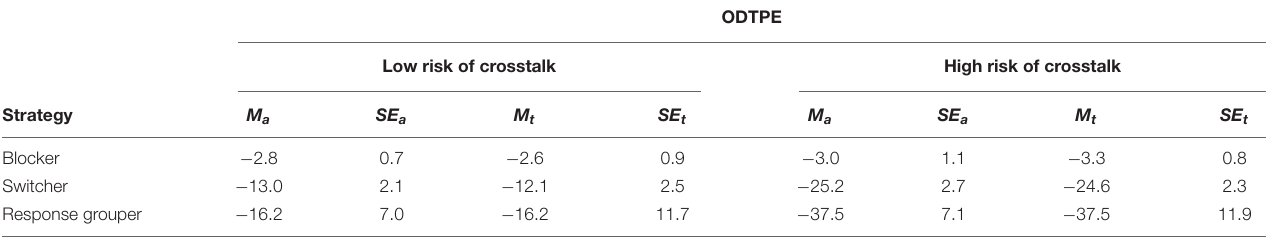
TABLE 3 | Comparison of mean overall dual-task performance efficiency (ODTPE) scores between crosstalk conditions. ODTPE Low risk of crosstalk High risk of